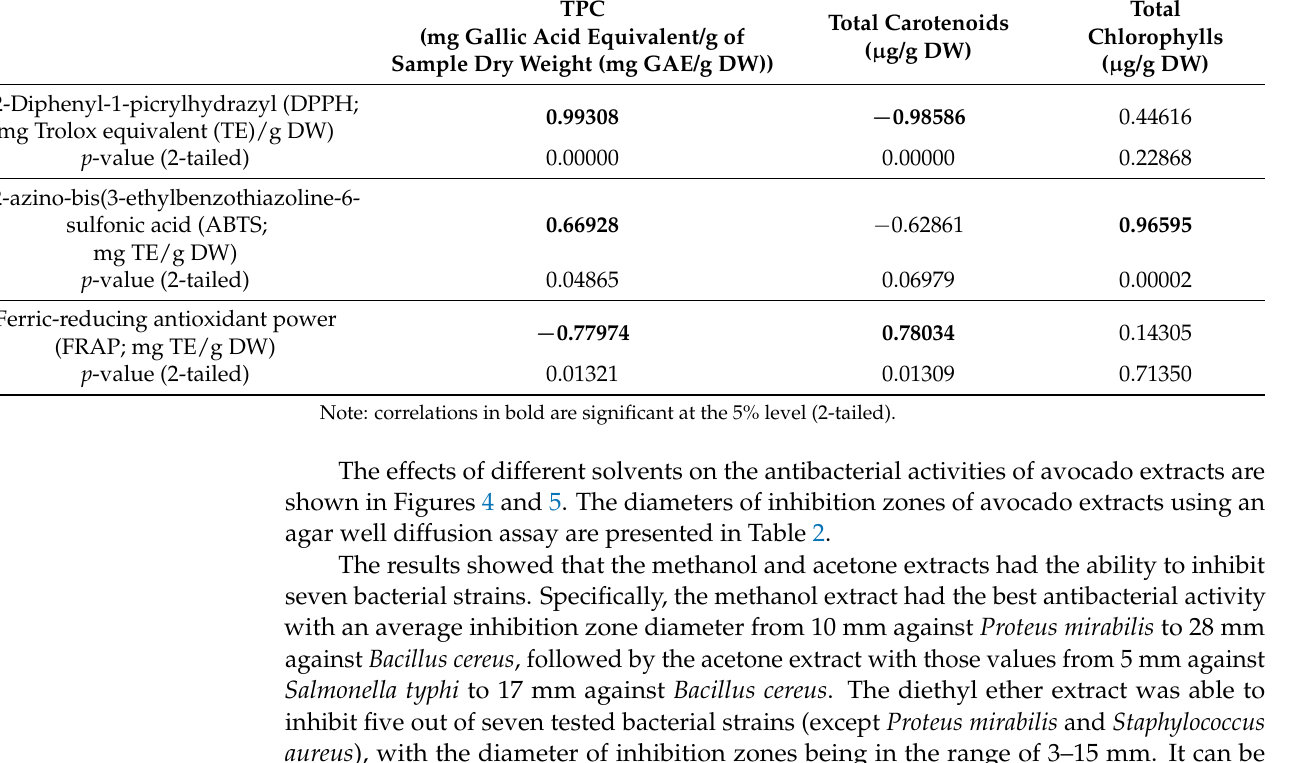
TPC Total Total Carotenoids (mg Gallic Acid Equivalent/g of Chlorophylls ( µ g/g DW) Sample Dry Weight (mg GAE/g DW)) ( µ g/g